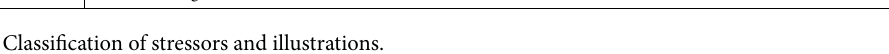
Table 1. Classification of stressors and